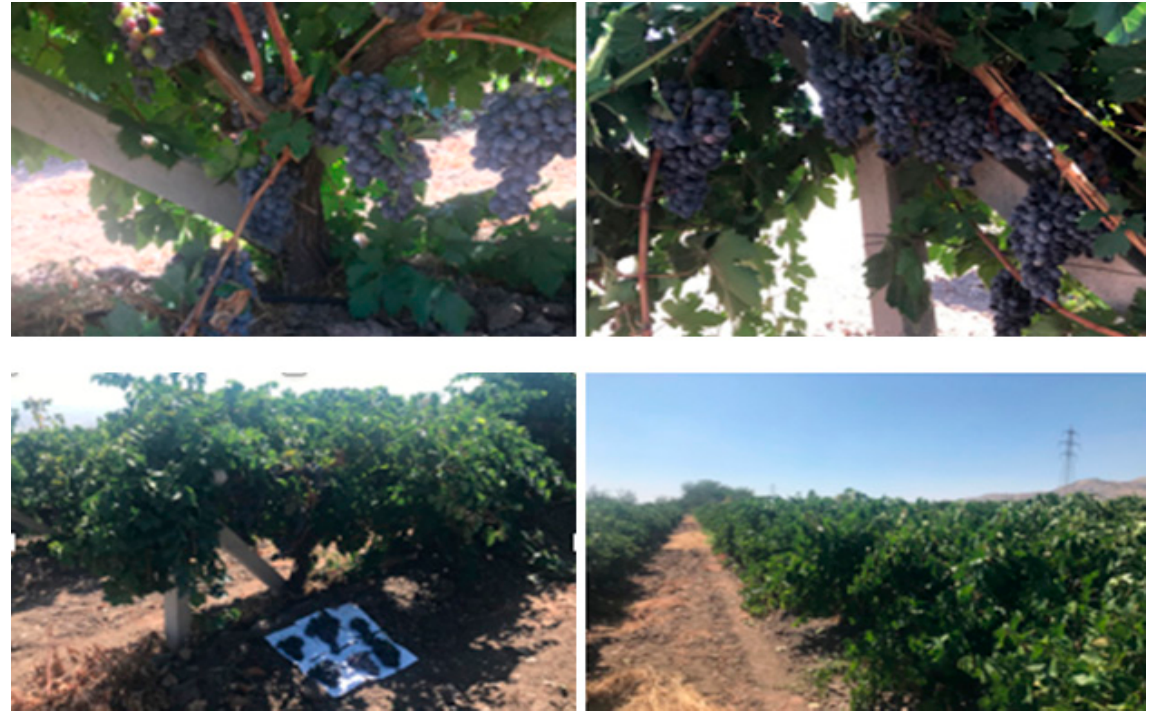
Figure 1. Different cluster forms (conical, irregular winged conical and winged conical) in ‘Köhnü’ grape clones.